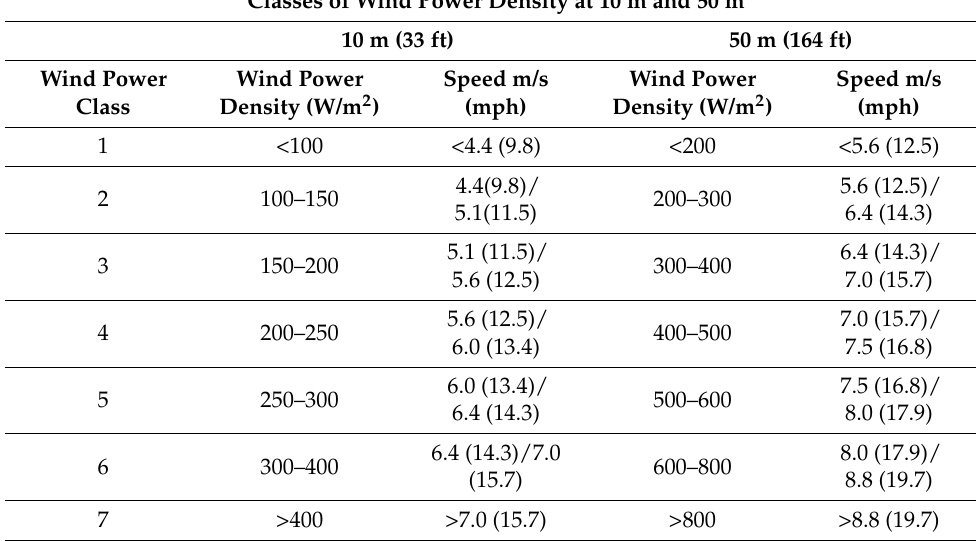
Table 1. Classes of wind power